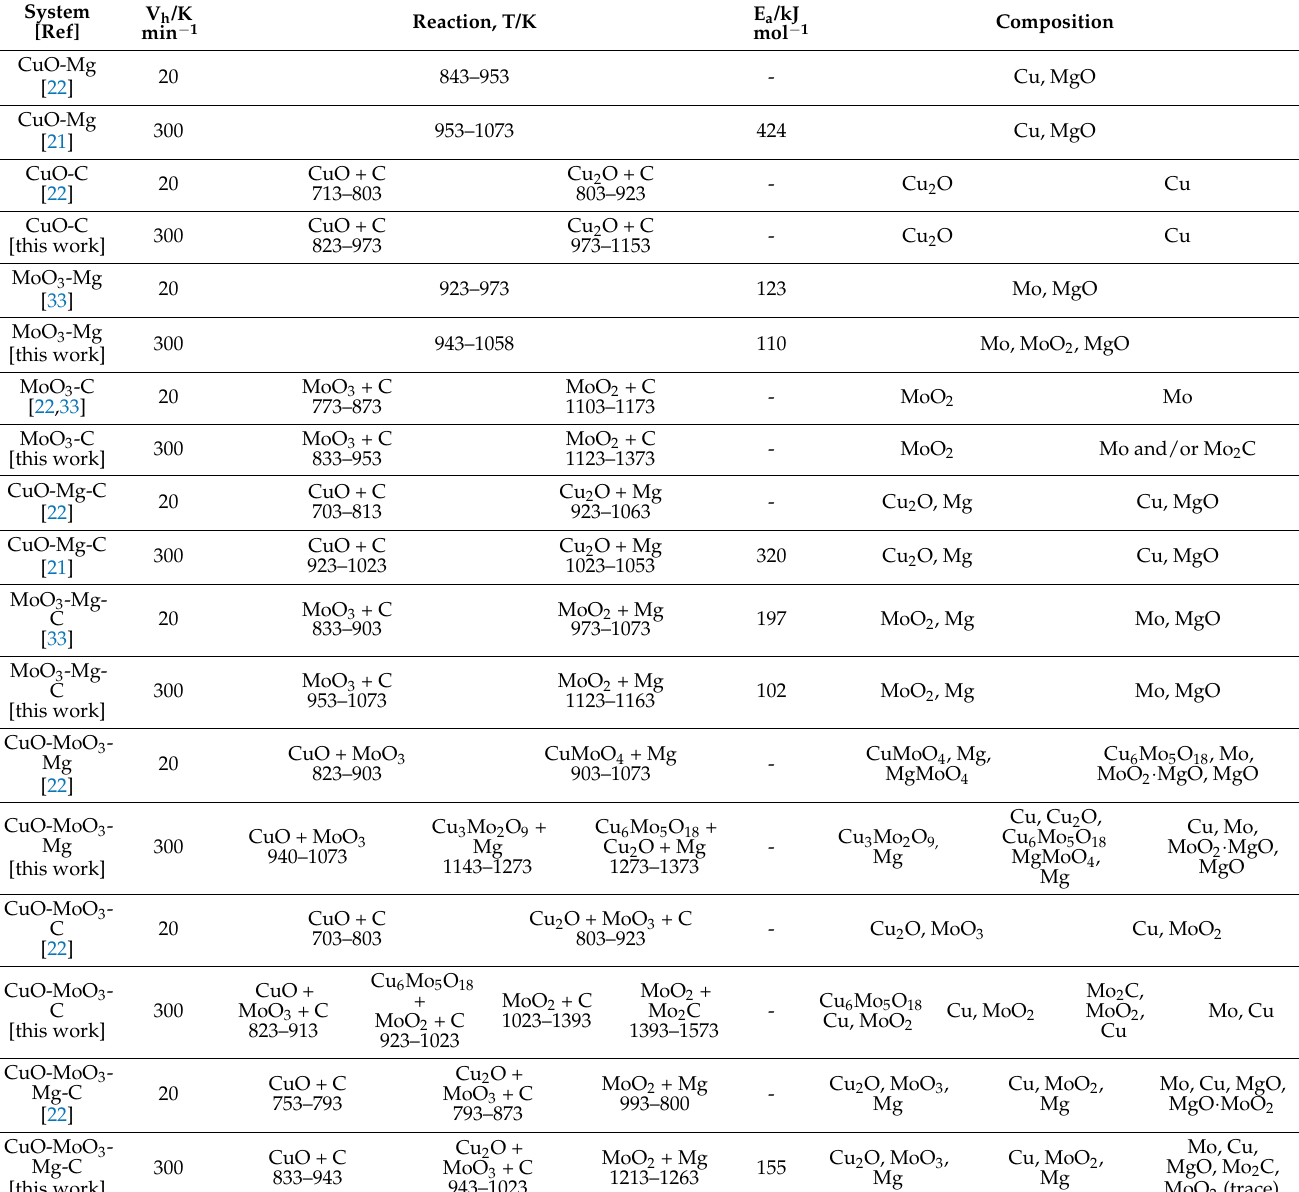
magnesium. The activation energy value of Cu 2 O + Mg reaction is 320 kJ mol − 1 , which is approximately three times higher than the activation energy value of the magnesiothermic reduction reaction in the MoO 3 + 1.5Mg + C mixture (Table 2). Table 2. Comparative overview of the CuO-C, MoO 3 -C, CuO-Mg, MoO 3 -Mg, CuO-MoO-C, CuO-MoO 3 -Mg, CuO-Mg-C, MoO 3 -Mg-C, CuO-MoO 3 -Mg-C systems at low (20 K min − 1 ) and high (300 K min − 1 ) heating